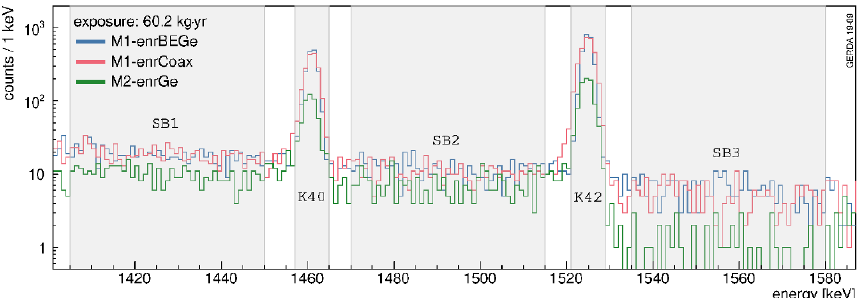
Visual representation of the (cid:12)ve energy ranges de(cid:12)ned for the potassium tracking analysis. The exact intervals and counts are given in table